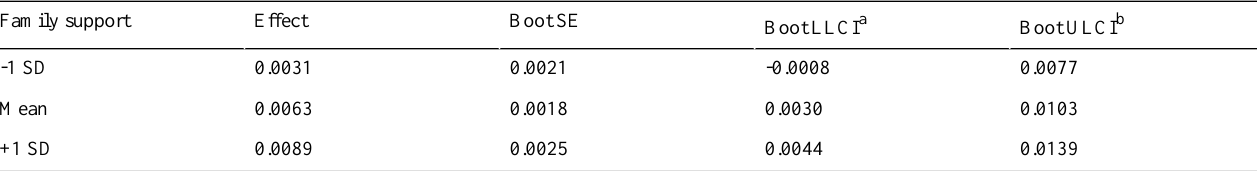
Table 3. Conditional indirect effects of introversion (Wave 1) on depression (Wave 3) at the value of perceived family support (Wave 1) through compensatory social networking sites use (Wave